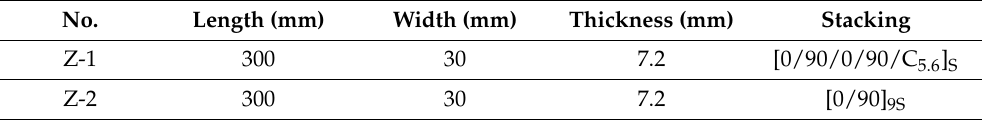
Table 3. Configurations of